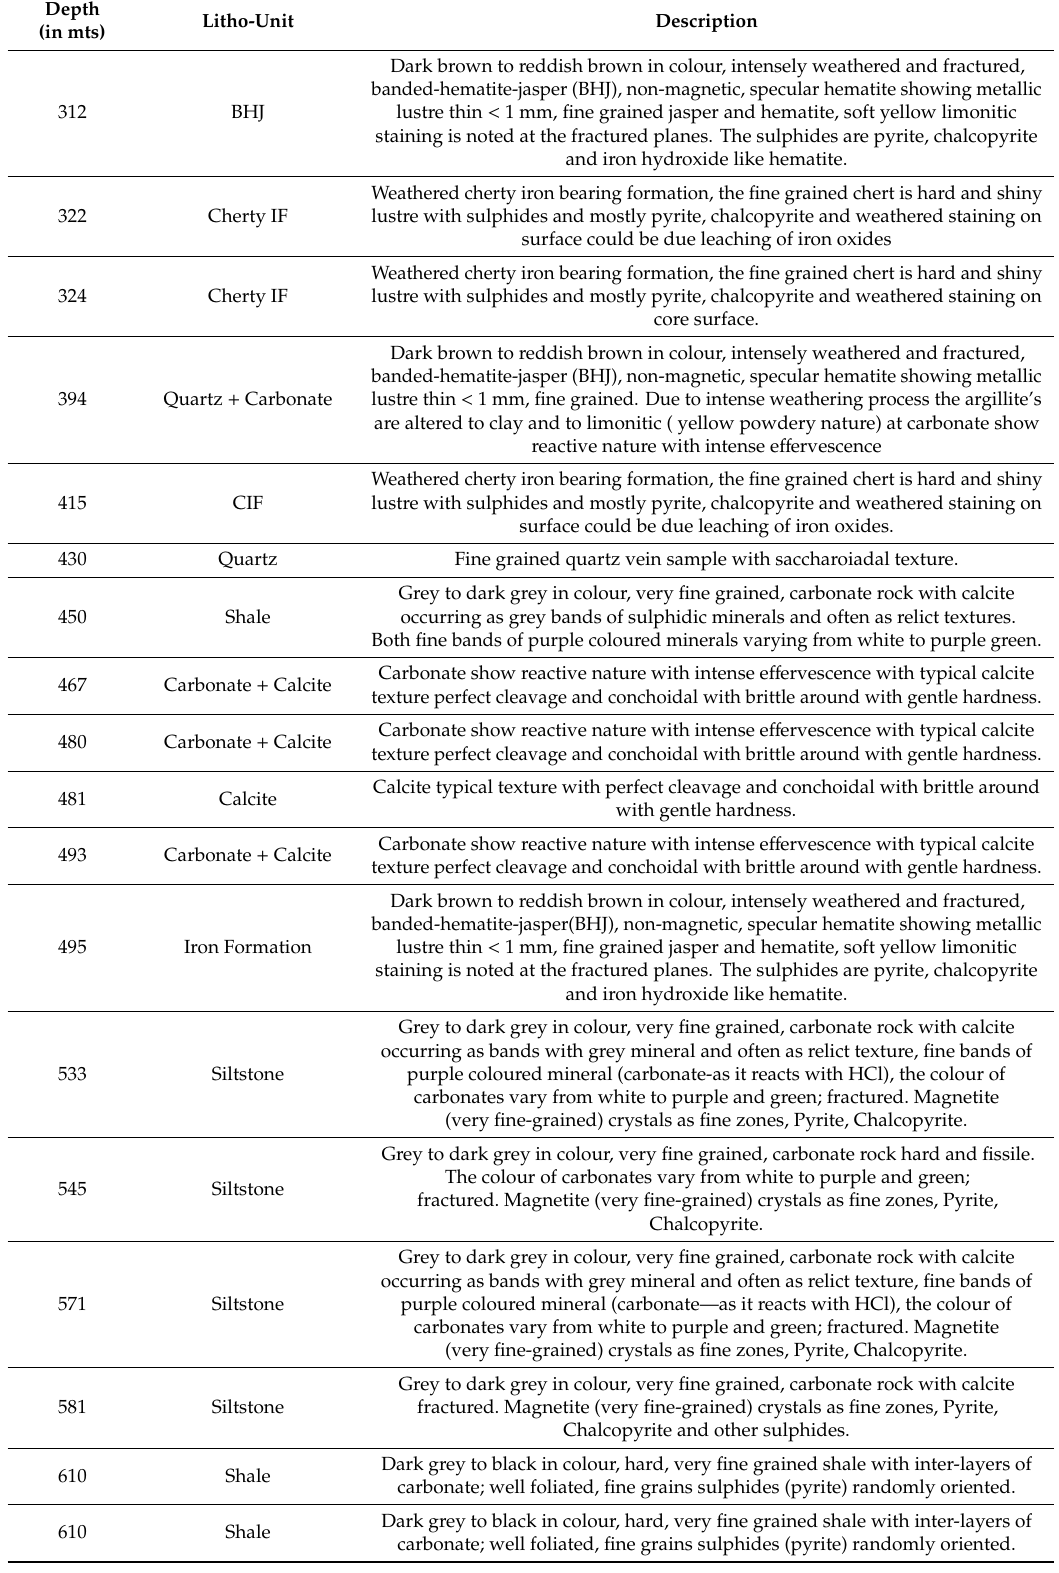
Table 2. Core section lithology of